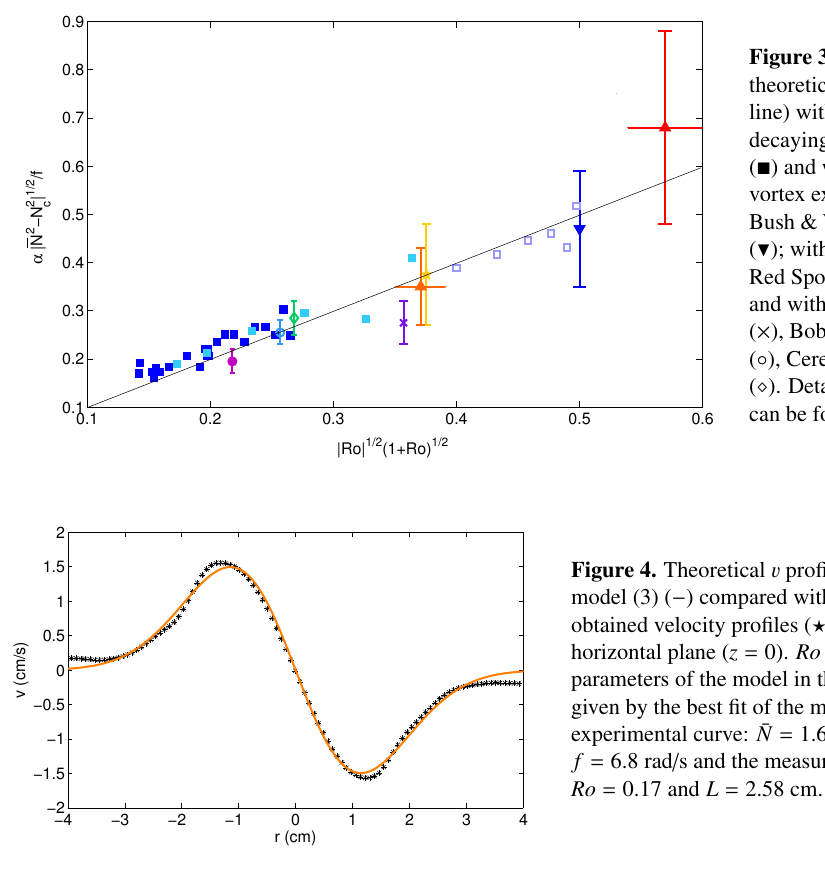
Figure 3. Tests of our theoretical law (2) (straight